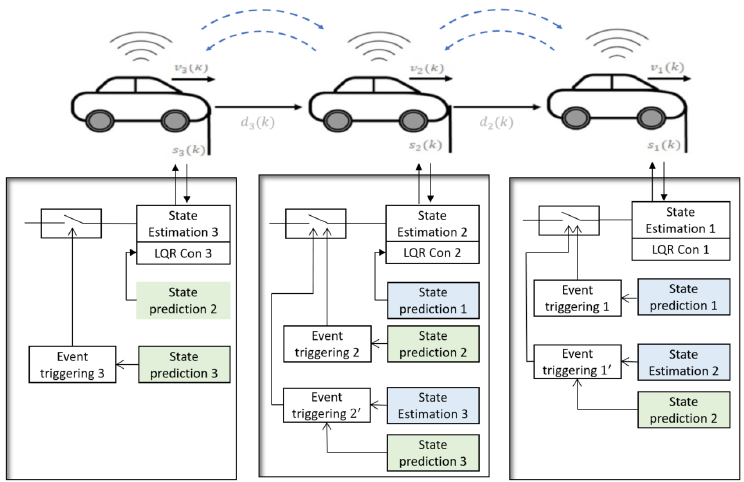
Figure 4. Schematic of vehicle platooning with the proposed event triggering